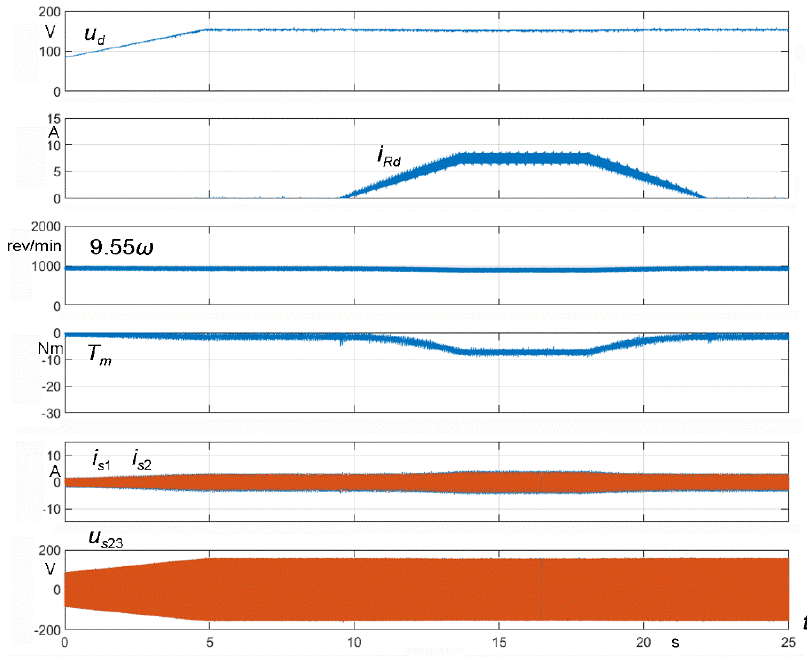
Figure 18. Excitation of the generator at Ω pu = 0.48, m = 2 and loading to P d ≈ 500